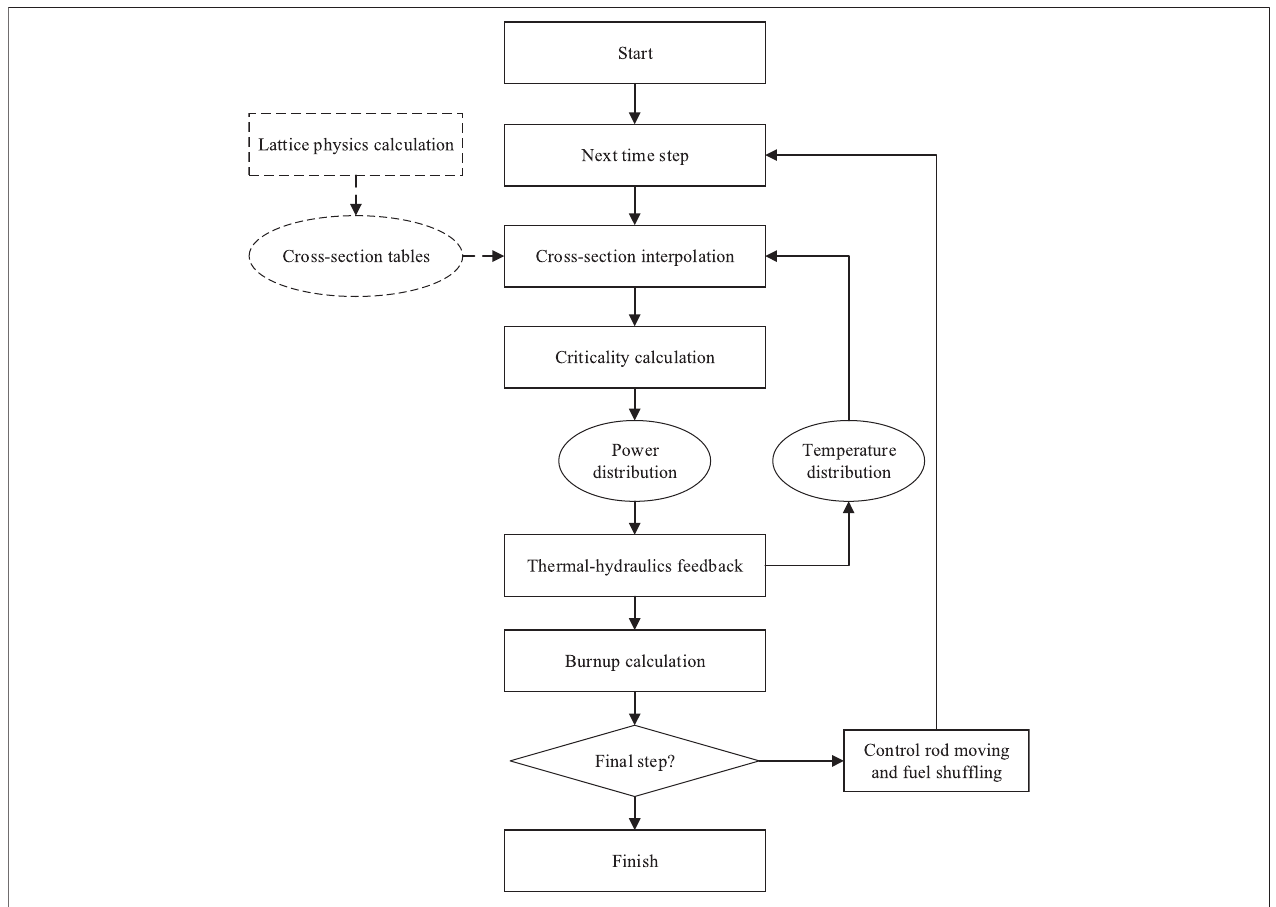
FIGURE 7 | Calculation fl ow of the PANGU code